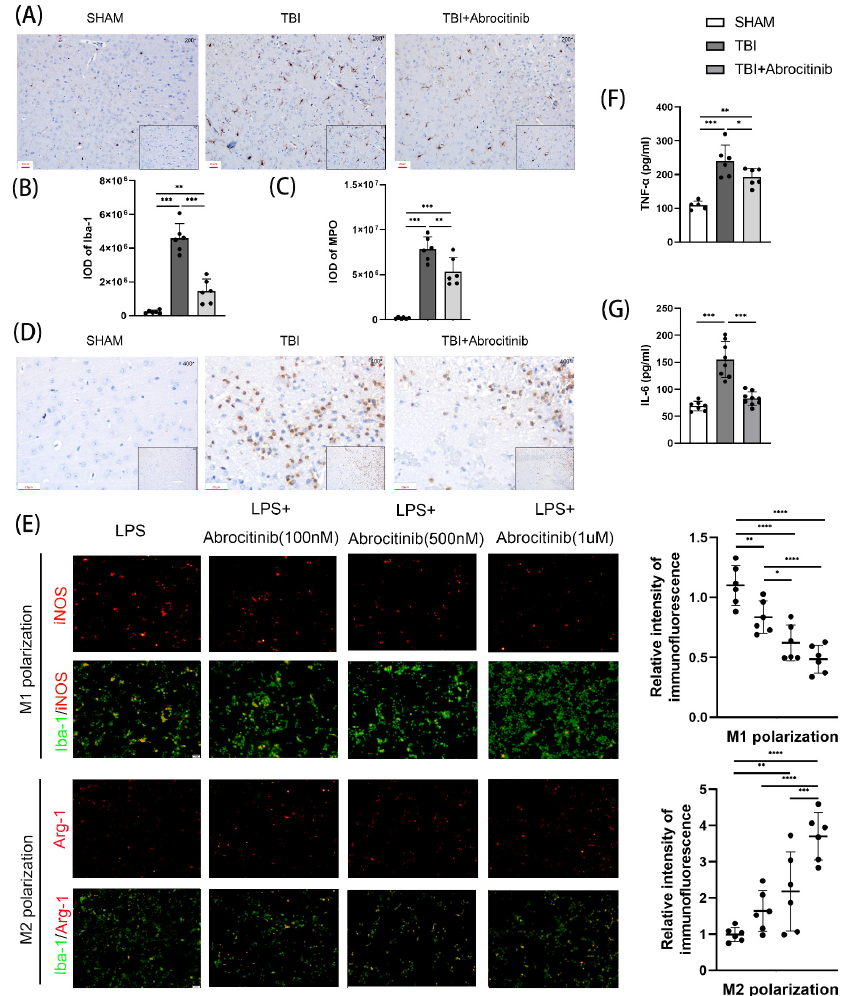
Figure 5. Changes in the infiltration of inflammatory cells and the activation of microglia. From the IHC staining, the increased neutrophils and microglia around the trauma focus caused by TBI were attenuated by abrocitinib ( A – D ) (n = 6 Kruskal-Wallis test). The effect of abrocitinib on LPS-mediated BV2 microglial polarization was also observed in vitro ( E ). M1-phenotype: iNOS + (red) and Iba-1 + (green); M2-phenotype: Arg-1 + (red) and Iba-1 + (green). Scale bar = 20 µ m (n = 6 one-way ANOVA with Tukey’s post-hoc test). The changes in inflammatory cytokines (IL-6 and TNF- α ) after brain injury and the effects of abrocitinib were determined with the help of ELISA ( F – G ) (n = 5–9 one-way ANOVA with Tukey’s post-hoc test). All data are shown as mean ± SD. * p < 0.05, ** p < 0.01, *** p < 0.001, **** p <